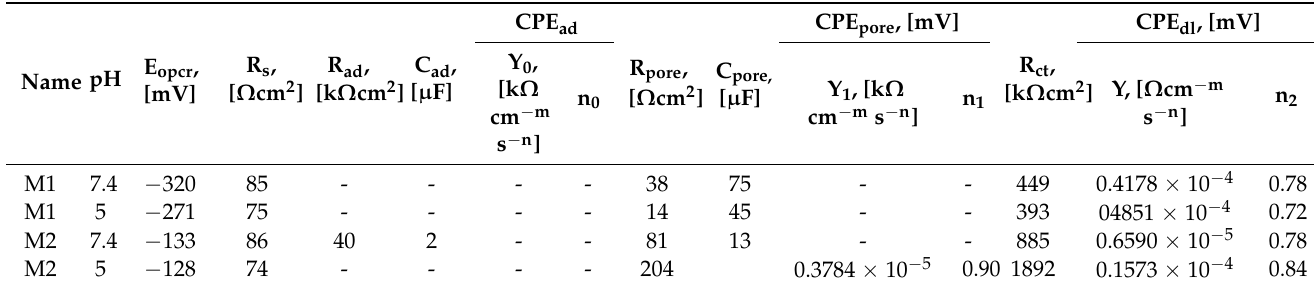
Table 4. Results of EIS test.